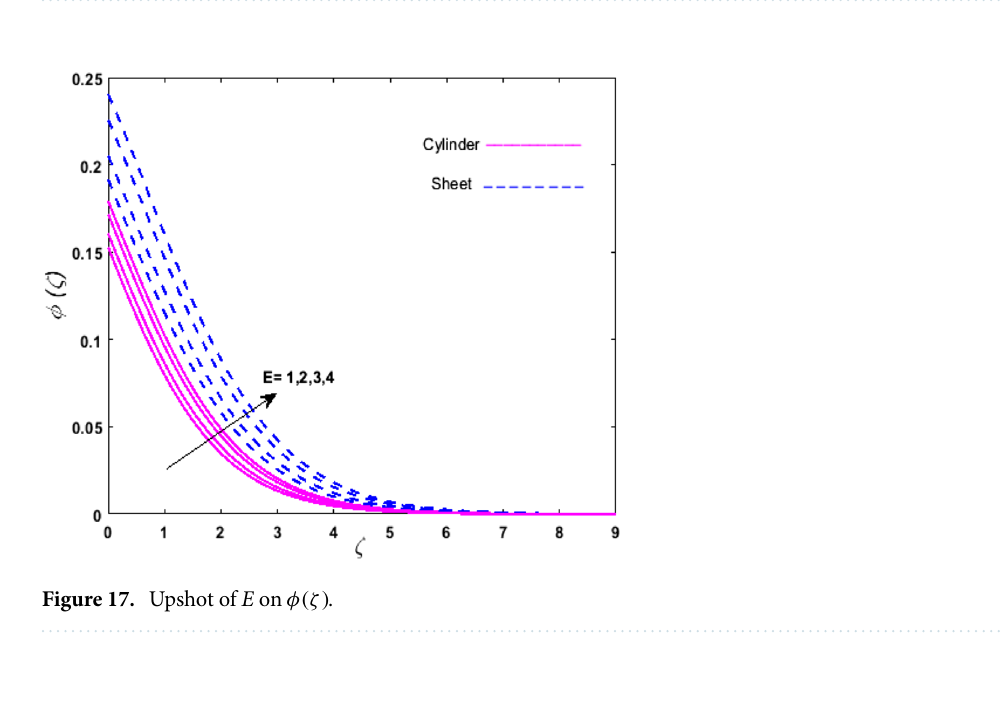
Figure 16. Upshot of H 2 on φ(ζ) .